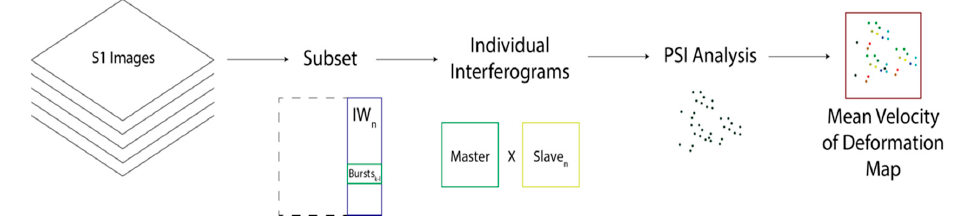
Sentinel Application Platform (SNAP) to compute interferograms. In workflow (ii), the interferogram series is analyzed within the Stanford Method for Persistent Scatterers (StaMPS) to retrieve a PS land deformation